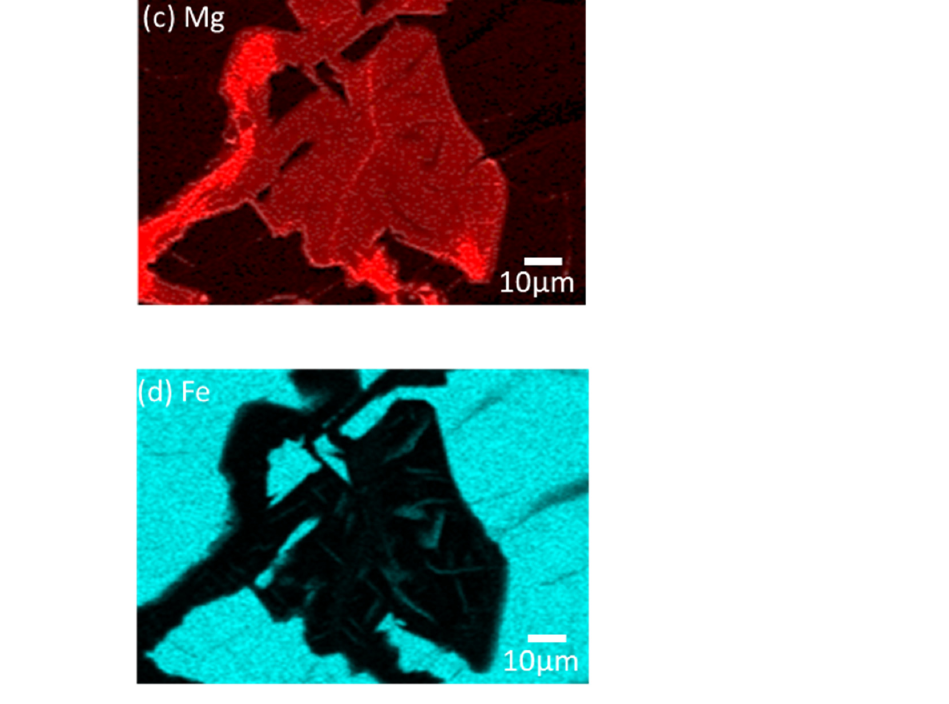
Figure 5. ( a ) Enlarged microstructure of (3) in Figure 3 and EDS mapping results of ( b ) B, ( c ) Mg, and ( d ) Fe (×500 magnification).